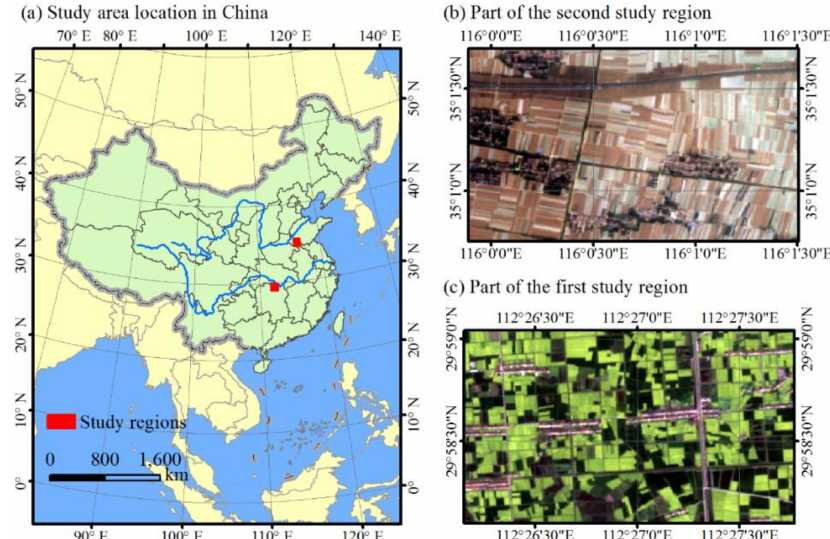
Figure 1. ( a ) Locations of the study areas in China (red). ( b ) Sentinel-2 image of part of the second study region on 21 October 2020. White and brown areas are winter garlic and winter wheat plots, respectively. ( c ) Sentinel-2 image of part of the first study region on 18 March 2020. Yellow and blackish-green areas are winter canola and winter wheat, respectively. These Sentinel-2 images have true RGB colour, i.e., R = red waveband, G = green waveband and B = blue